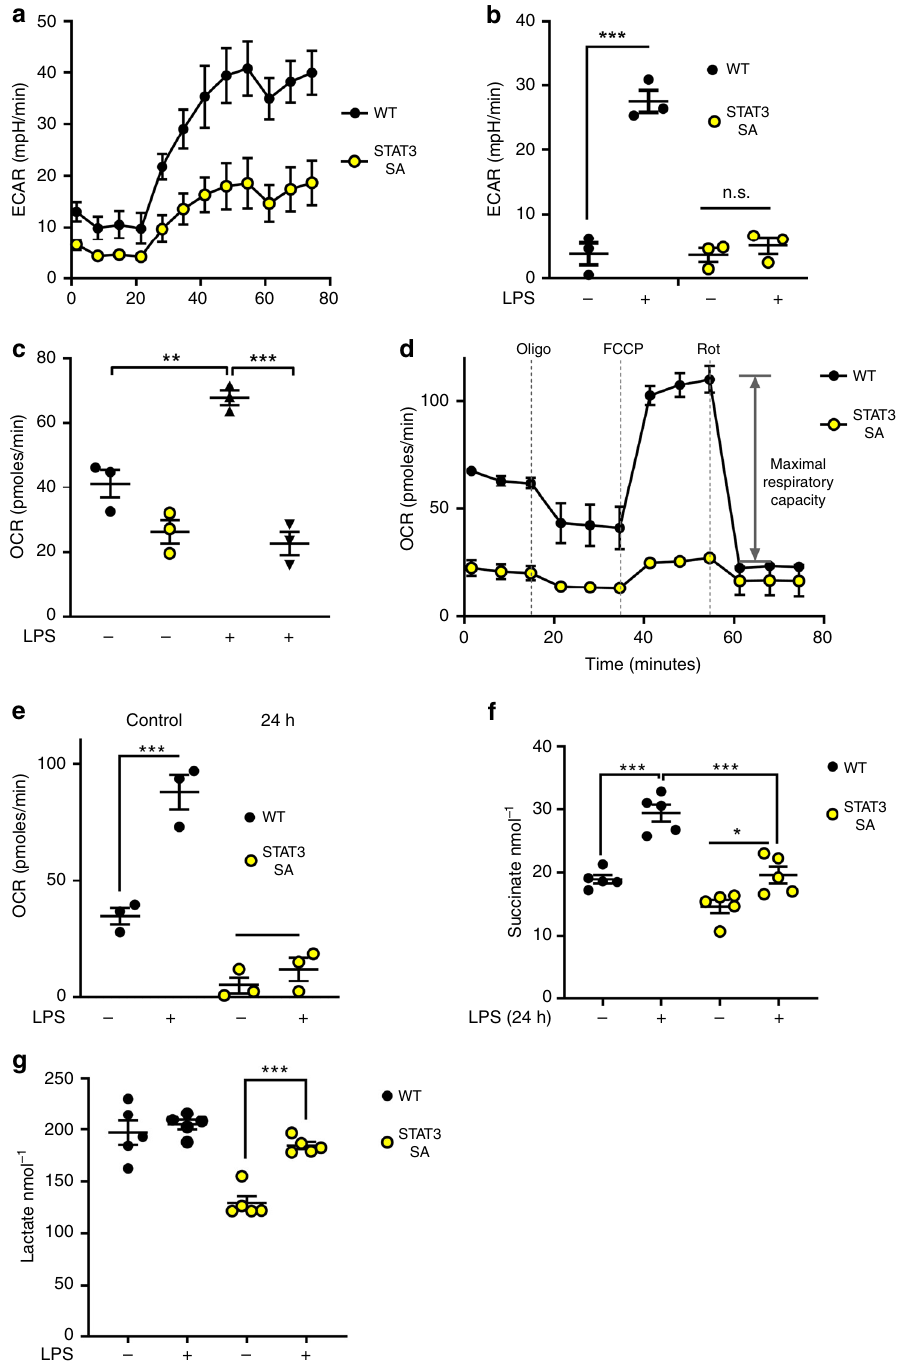
Fig. 4 STAT3 pSer727 is required for LPS-induced metabolic reprogramming. a Peritoneal macrophages (1 × 10 5 /well) obtained from WT vs STAT3 SA mice ( n = 3 per genotype). Real-time changes in the extracellular acidi fi cation rate (ECAR) of WT and STAT3 SA macrophages treated with LPS ( b , c ) WT and STAT3 SA peritoneal macrophages were stimulated with LPS or vehicle as indicated for 24 h. b *** p < 0.0001, and c ** p = 0.0034, *** p < 0.0001. a , b The ECAR and oxygen consumption rate (OCR) were analysed as indicators of oxidative phosphorylation and glycolysis, using a Seahorse XFp analyser. d Peritoneal macrophages were assayed for real-time changes in the OCR by sequential treatment with sequential treatment of cells with electron train chain inhibitors (oligomycin: adenosine triphosphate (ATP) synthase inhibitor; FCCP: H + ionophore cyanide p-tri fl urmethooxyphenyl-hydrozone; and Complex I inhibitor rotenone). e Comparison of maximal respiratory capacity (MRC) between WT and STAT3 SA peritoneal macrophages stimulated with LPS or vehicle for 24 h. Results presented ( a – e ) as the mean ± S.E.M of peritoneal macrophages obtained from three individual mice per genotype, *** p = 0.0004, One-way ANOVA with Tukey ’ s multiple comparisons test ( f – g ) Peritoneal macrophages obtained from individual mice were seeded at 1 × 10 5 cells/well and stimulated with LPS (100 ng/ml) for 24 h prior to analysis of metabolites succinate and lactate produced in WT and STAT3 SA cultured supernatants. Data presented as mean values of duplicate technical replicates ± SEM of fi ve individual mice per genotype, f * p = 0.0292, *** p < 0.0001 g *** p = 0.0004, One-way ANOVA with Tukey ’ s multiple comparisons